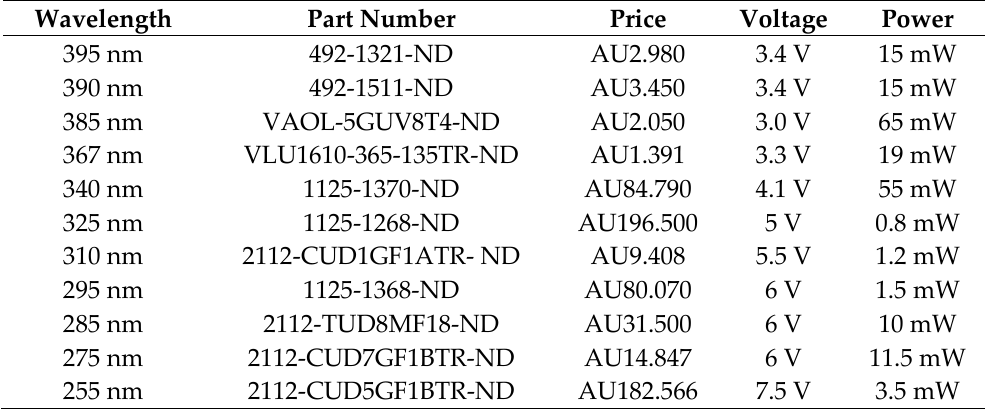
Table 1. Filtered UV-LEDs